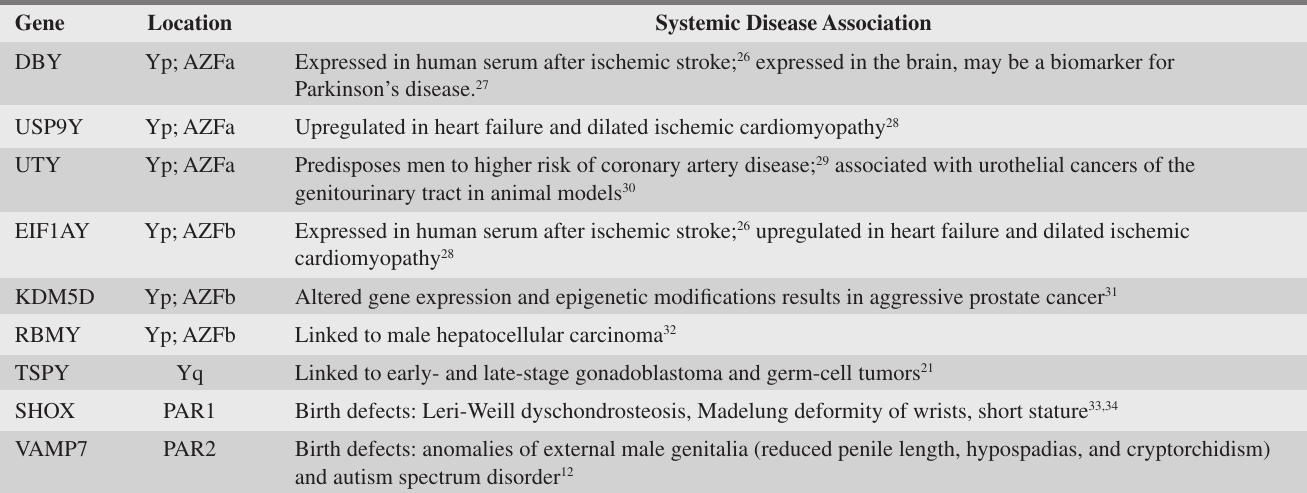
Table 1. Systemic Diseases and Conditions Associated with Y Chromosome Gene Alterations Gene Location Systemic Disease